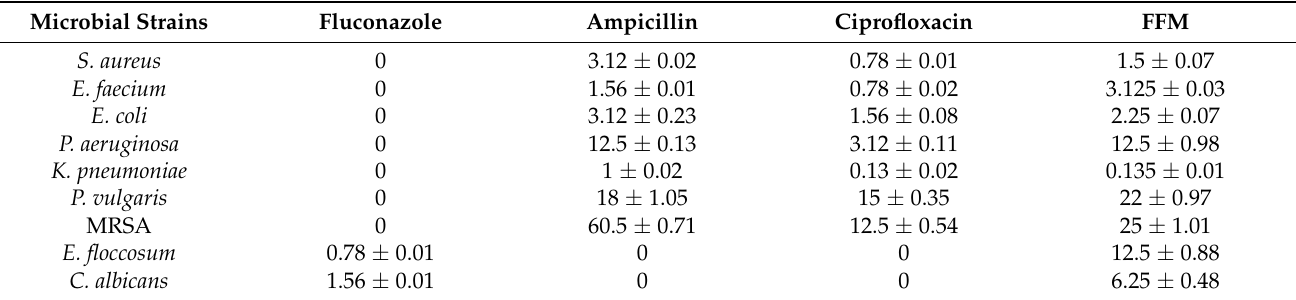
Table 2. MIC values ( µ g/mL) of FFM and positive